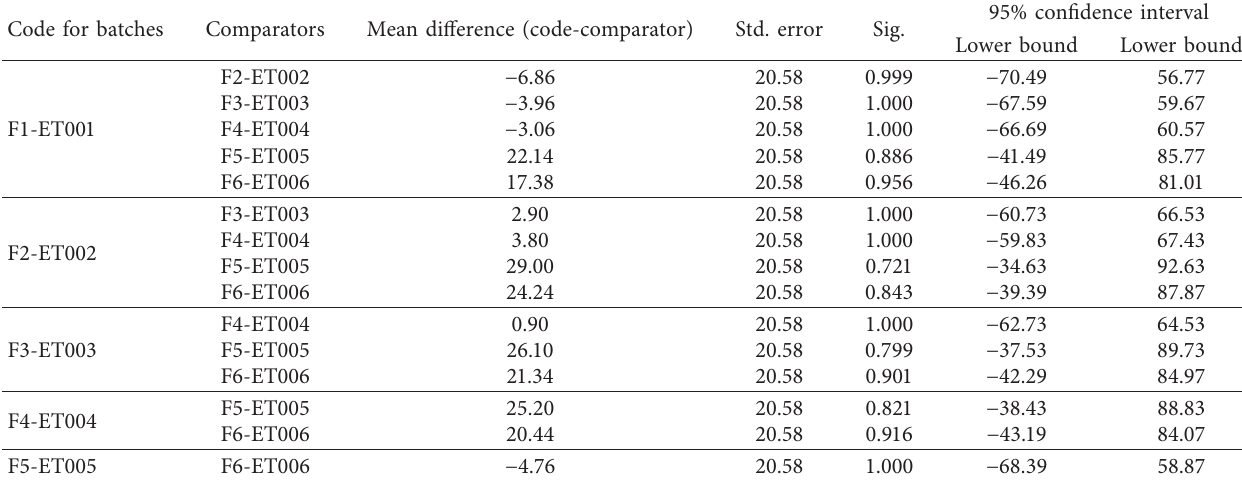
Table 5: Tukey’s multiple comparisons test for weight variation of ethambutol hydrochloride tablet batches tested with each other. Code for